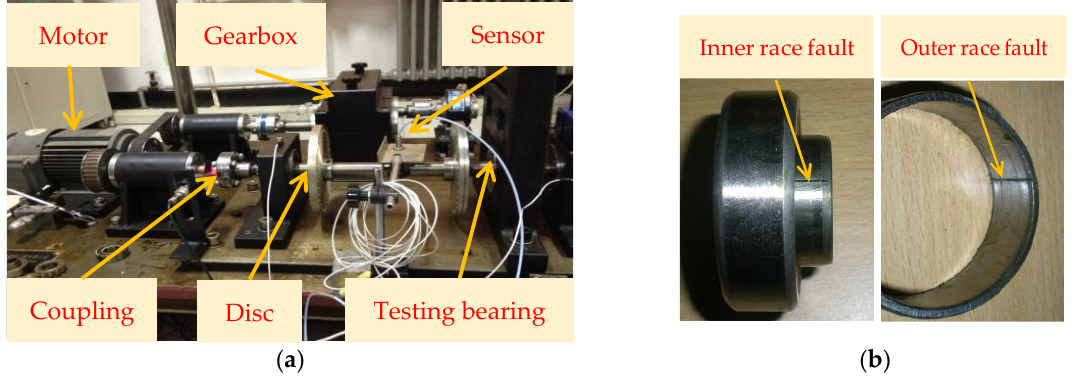
Figure 11. ( a ) Experimental platform; ( b ) the faulty bearing. Table 1. Specification parameter of experimental bearing.